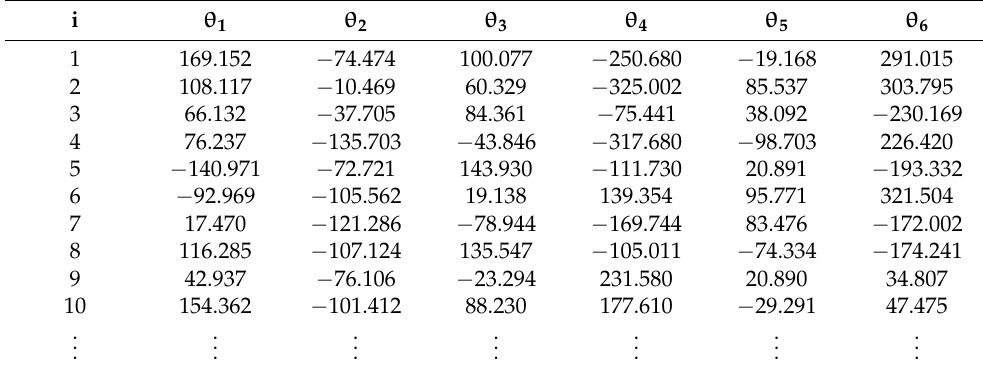
Figure 7. The data acquisition platform. Table 4. Joint angles sample data. The row represents joint angles, the column represents the sample number.